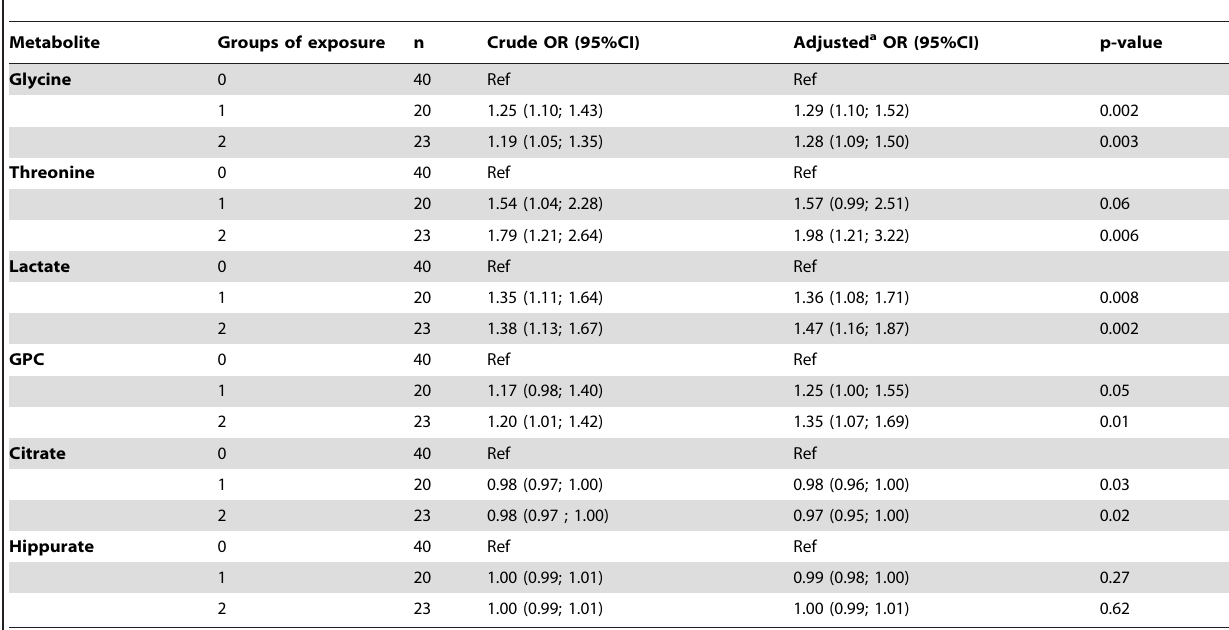
Table 3. Association between urinary metabolite changes in pregnant women and exposure to pesticides (assessed from the percentage of the surface of land dedicated to cereal crops in the town of residence in early